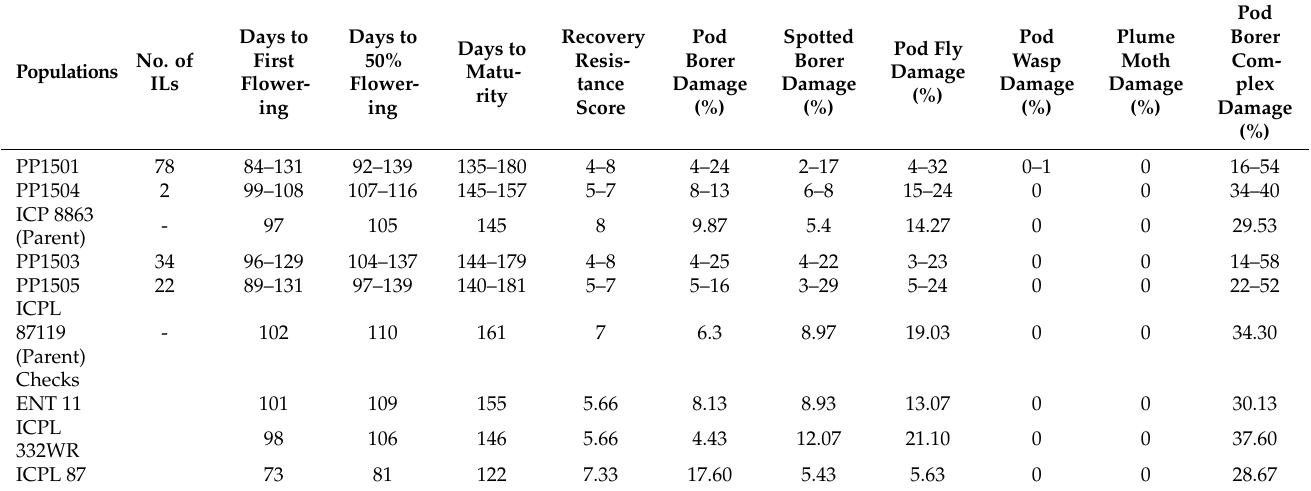
Table 4. Evaluation of 136 selected introgression lines (ILs), parents and checks for resistance to pod borer complex during the 2019 rainy season at Warangal,